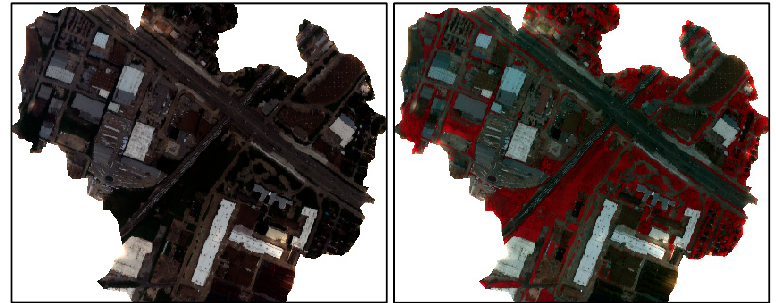
Figure 3. Hyperspectral imagery in cloud-shadow areas, true color display (left) and false color display (right).